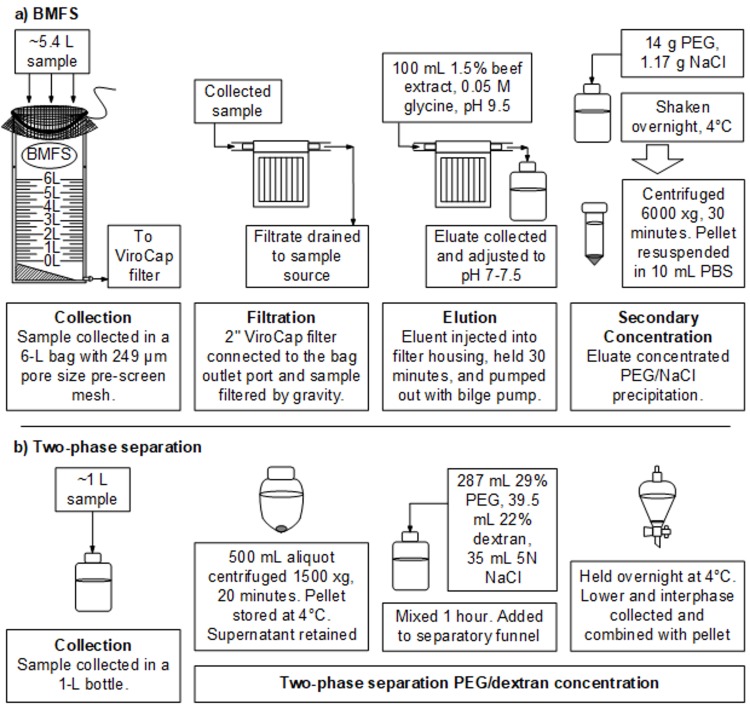
Workflow of the a) bag-mediated filtration system (BMFS) and b) two-phase method. PEG is polyethylene glycol. NaCl is sodium chloride. PBS is phosphate-buffered saline.